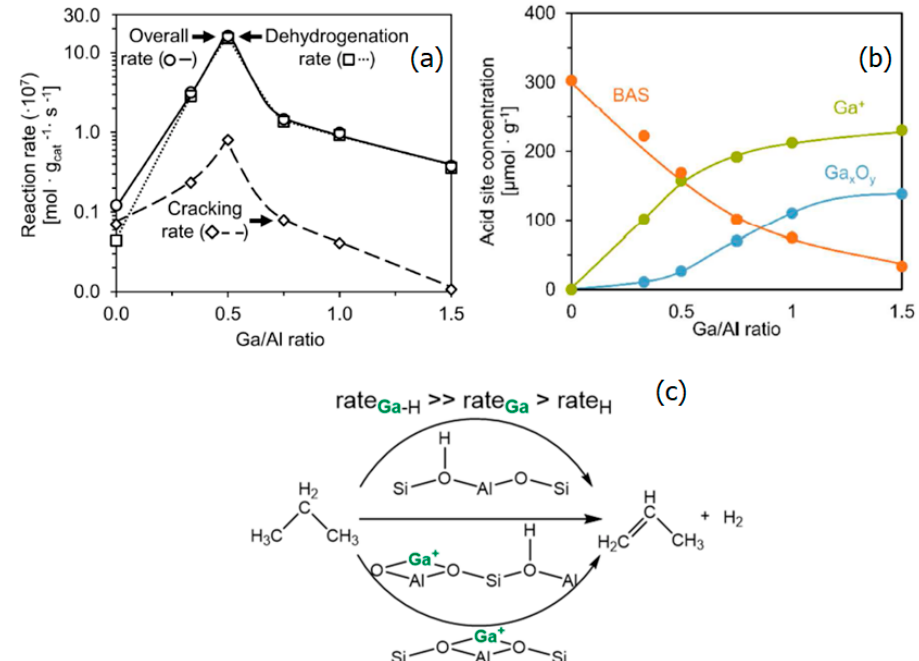
Figure 4. Influence of Ga content on reaction rate ( a ) and acid site concentration ( b ). Reaction mechanism of propane dehydrogenation over Ga − based catalysts ( c ). Reprinted with permission from ref. [94]. Copyright 2018 American Chemical Society.